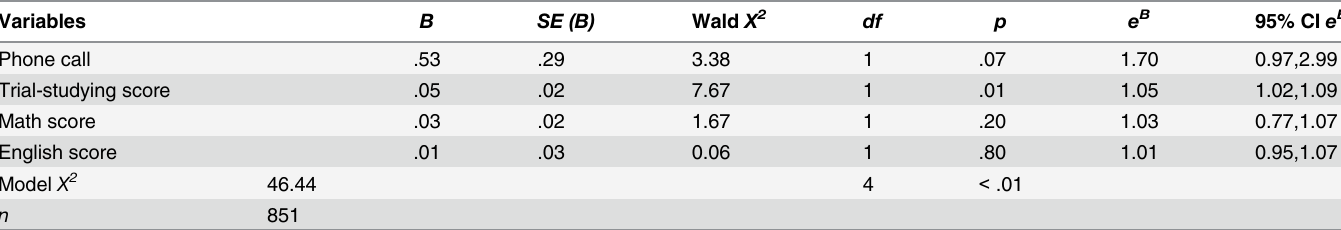
Table 5. Logistic Regression Results for Predicting Enrollment Based on Selection-test